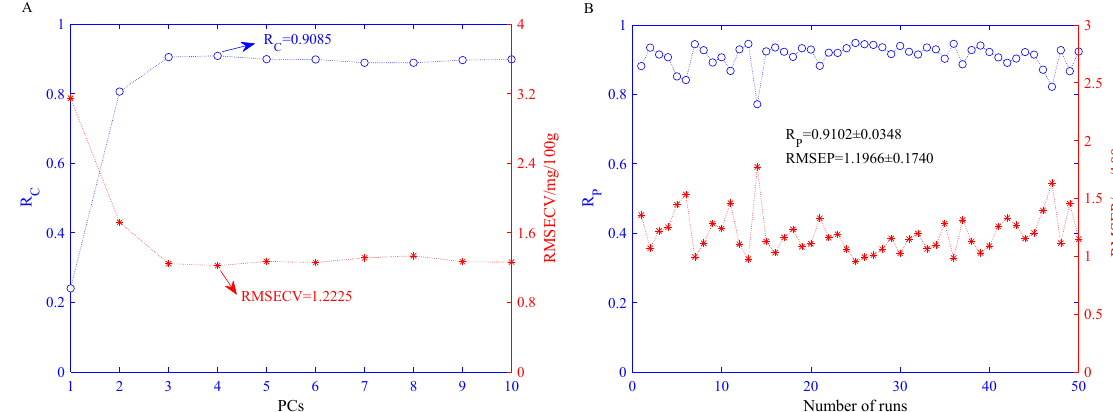
Figure 6. Statistical results of BPNN model based on portable NIR spectroscopy features after 50 independent runs. ( A ) Statistical results of BPNN models established under different PCs in the training set; ( B ) statistical results of the BPNN models established when PCs = 4 in the prediction set.